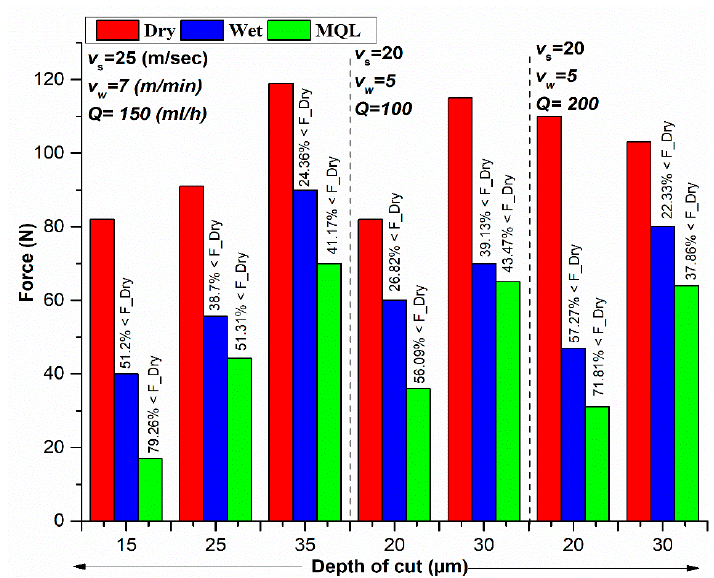
Figure 3. Comparison of force measurements in different cooling environments.